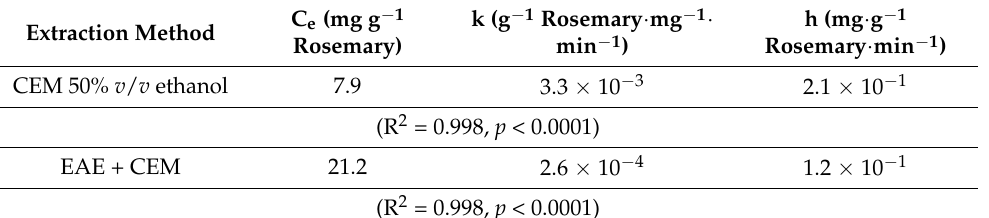
Figure 4. Effect of extraction time on TPC during ( ( • ) EAE + CEM. Dashed lines are the non-linear fitting curves (Equation (2)). Table 6. Kinetic parameters of conventional extraction and EAE + CEM. Extraction